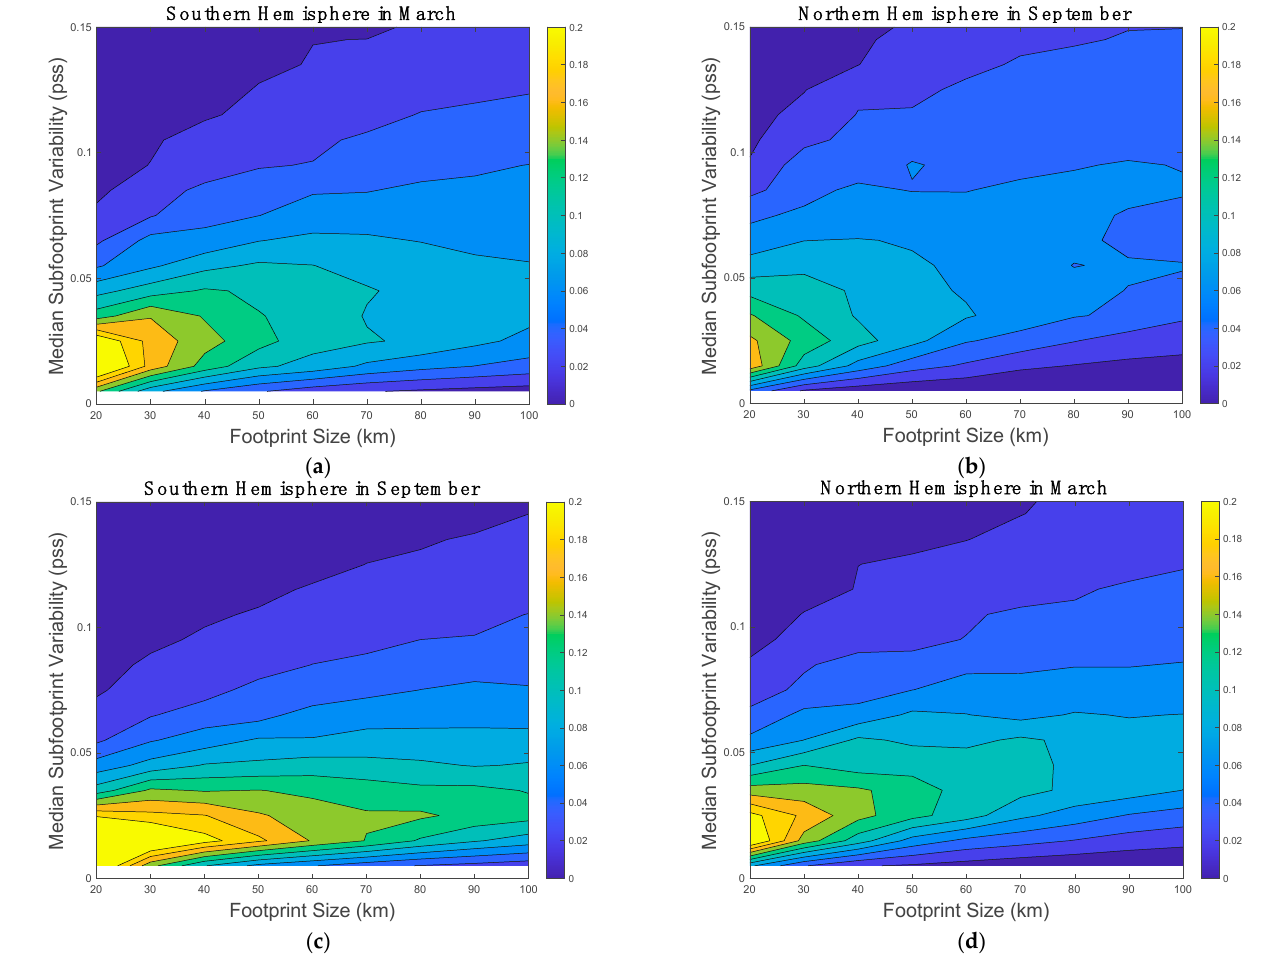
Figure 5. Distributions of SFV as a function of footprint size broken out by hemisphere and season. For example, the values for 100 km are determined by taking a histogram of the data displayed in Figure 3a. Note that these are normalized histograms, so the values displayed do not depend on the relative areas of the southern and northern hemisphere oceans. Left column is the southern hemisphere, and right is northern. Top row is the fall season, and bottom is spring. ( a ) Southern hemisphere in March. ( b ) Northern hemisphere in September. ( c ) Southern hemisphere in September. ( d ) Northern hemisphere in